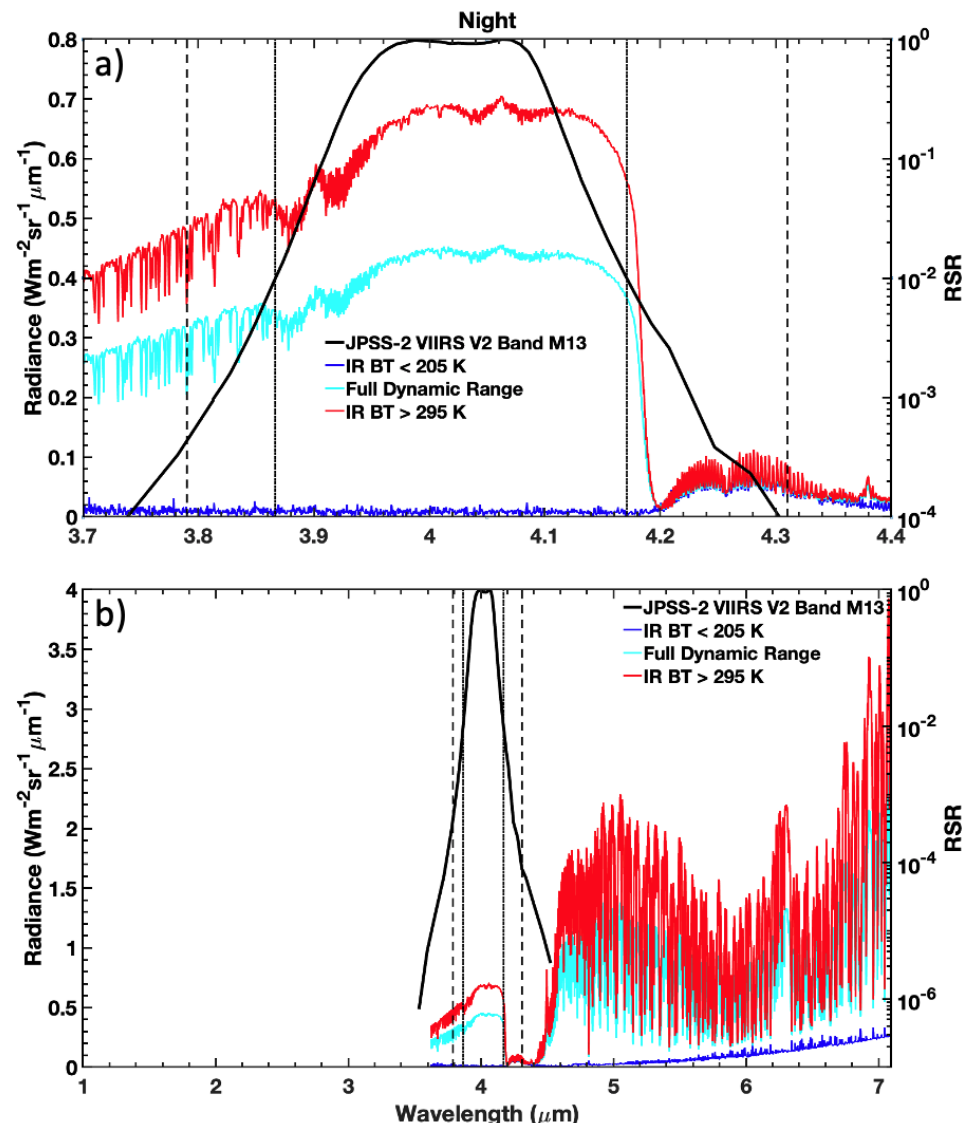
Table 12 summarizes γ for VIIRS mid-wave IR bands I4, M12, and M13 based on measured 1% extended bandpass limits, separated by day and night IASI measurements. As in Table 11, Aqua MODIS 11- µ m band-integrated IASI IR BT limits are also considered. With an overall smaller magnitude compared to Figure 7a, Figure 8a reveals the nighttime-only, temperature-dependent Earth-emitted radiance spectra with JPSS-2 VIIRS V2 band M13 RSR and extended bandpass limit information overlaid. Even though the JPSS-2 VIIRS V2 band M13 OOB measurement range is significantly narrower than that of S-NPP VIIRS GT, Figure 8b o ff ers the same rescaled view as that of Figure 7b for the sake of comparison.